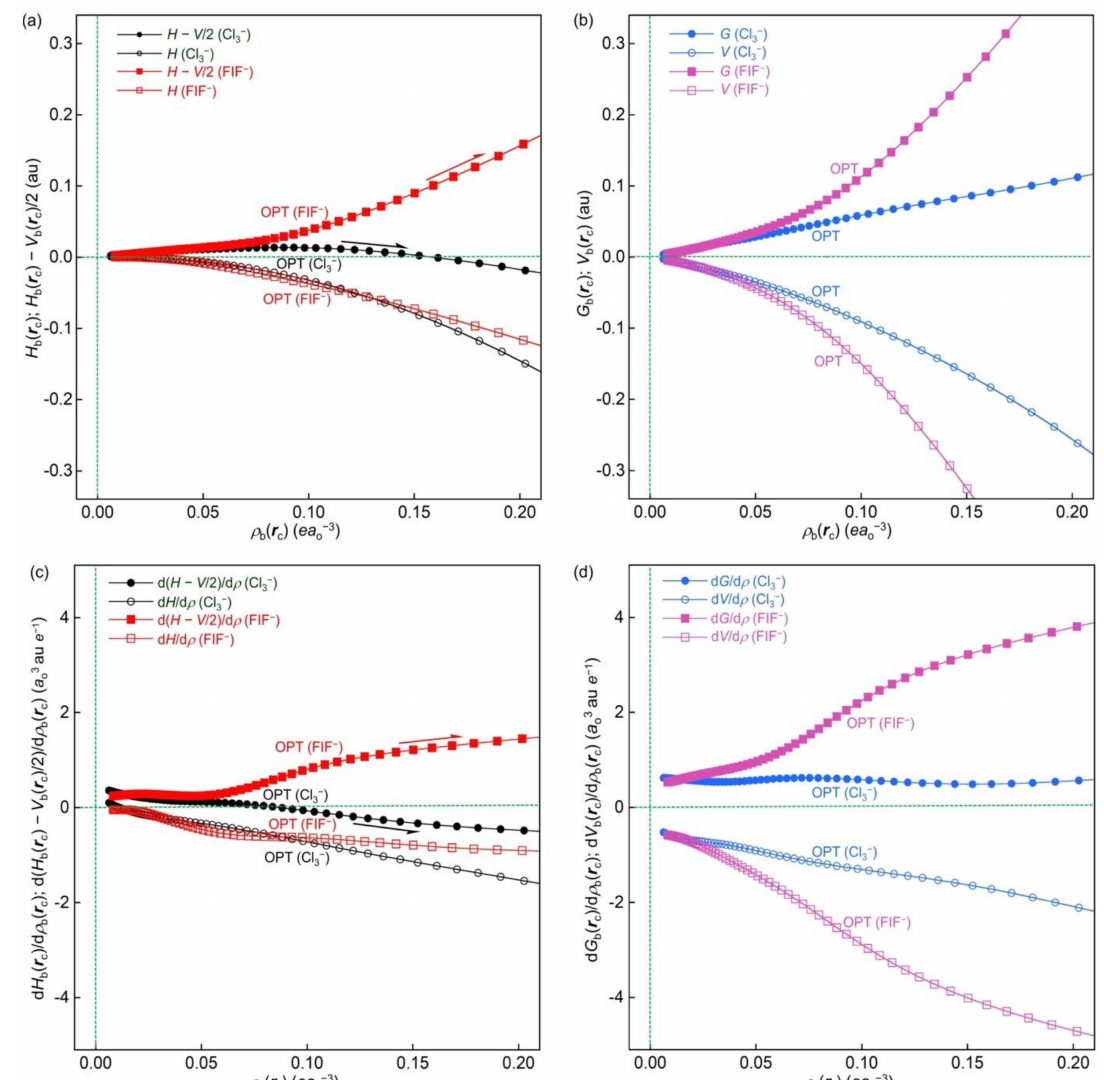
Figure 12. Plots of H b ( r c ) − V b ( r c )/2 and H b ( r c ) versus ρ b ( r c ) ( a ) G b ( r c ) and V b ( r c ) versus ρ b ( r c ) ( b ) for the wide range of interaction distances for [F–I- ∗ -F] − and [Cl–Cl- ∗ -Cl] − , calculated with MP2/BSS-C. The perturbed structures are generated with POM. Plots of d( H b ( r c ) − V b ( r c )/2)/d ρ b ( r c ) and d H b ( r c )/d ρ b ( r c ) versus ρ b ( r c ) ( c ) and dG b ( r c )/d ρ b ( r c ) and d V b ( r c )/d ρ b ( r c ) versus ρ b ( r c ) ( d ), corresponding to ( a ) and ( b ),